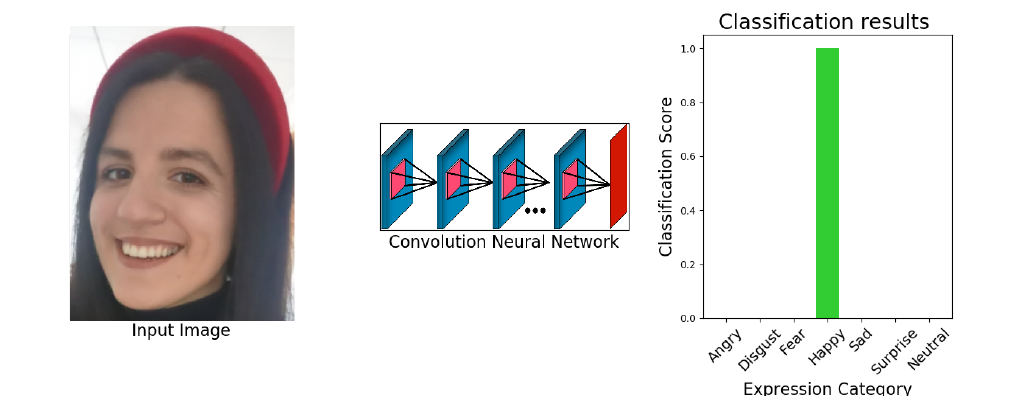
Figure 1. Visualization of